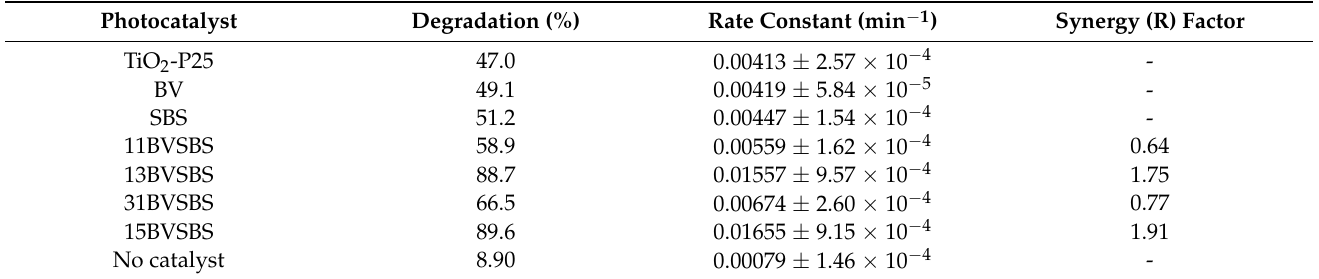
Table 2. Degradation efficacy, rate constant, and synergistic factor of the prepared photocatalysts.